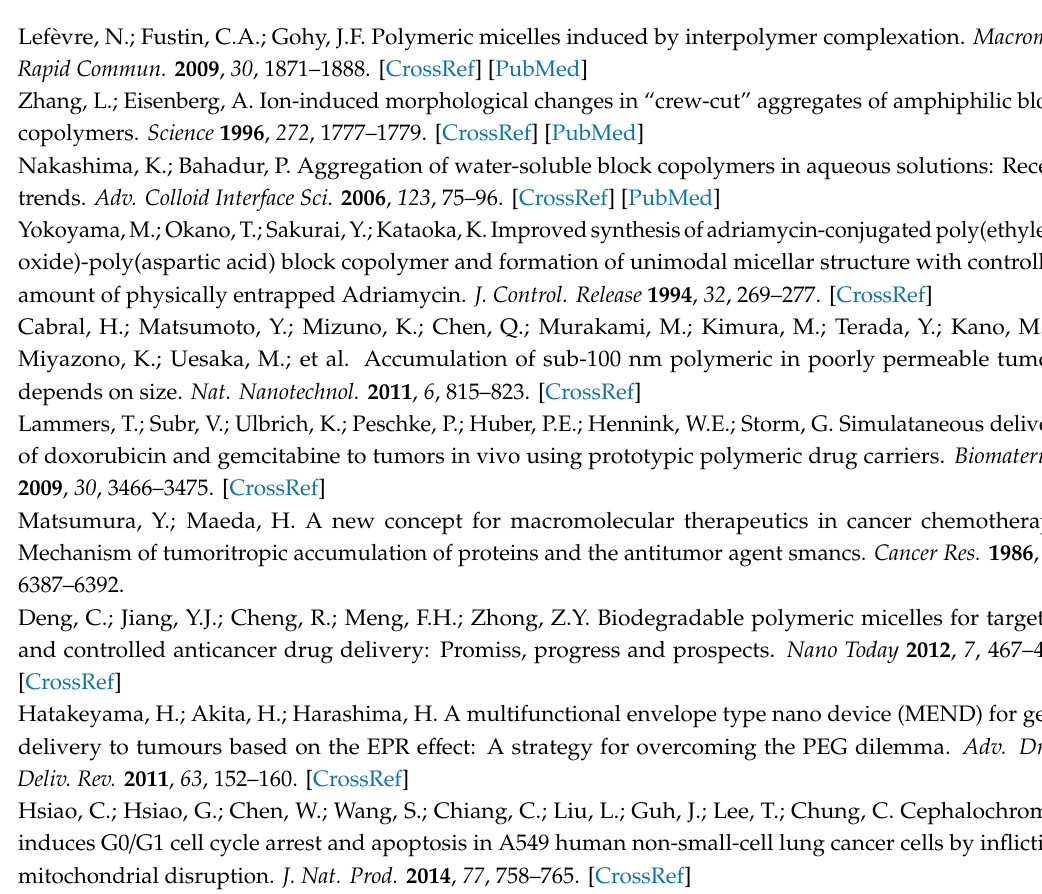
Figure S1. (a) TEM images of PEG 54 -P(AA / VE6 / γ TCP29) 140 at C p = 0.10 g / L in PBS bu ff er of pH 7.4, in acetate bu ff er of pH 5.2 (b) just after preparation and (c) after 60